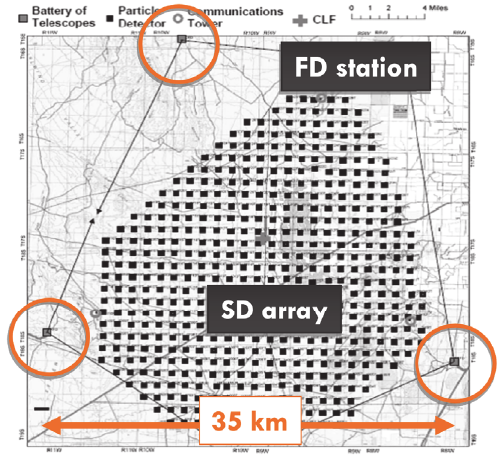
Figure 1. Layout of the Telescope Array (TA) experiment. The black squares are the TA surface detector (SD) counters, and the gray squares are the TA fluorescence detector (FD) stations. The arrows from the FD stations represent the each FD’s viewing ranges. The distance scale of two southern FD stations is approx- imately 35